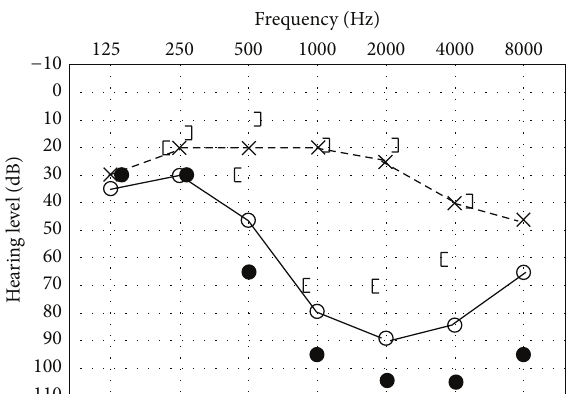
Figure 2: Audiogram before and after surgery. Filled circles indicate hearing level in the right ear after